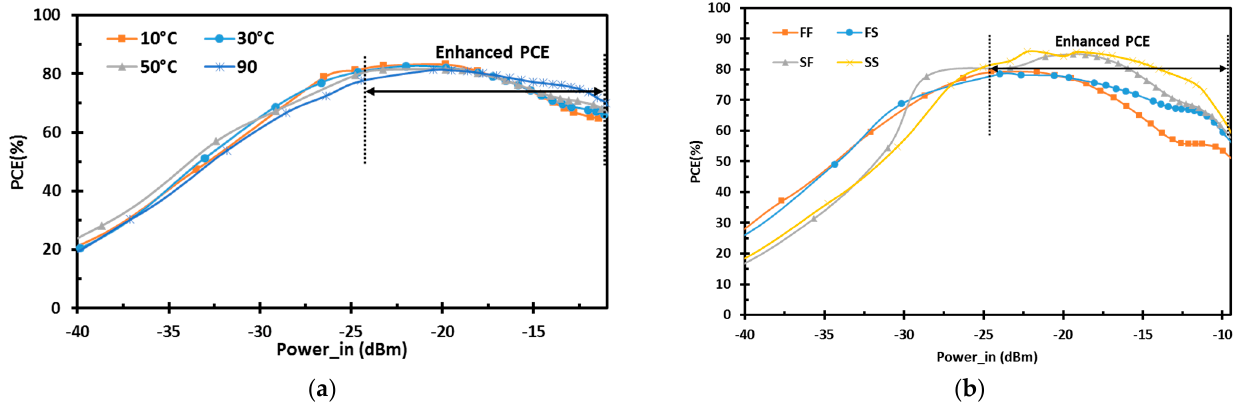
Figure 10. Simulation results showing the variation of the PCE for the proposed rectifier vs. input RF power at ( a ) different temperature levels; ( b ) process corners.